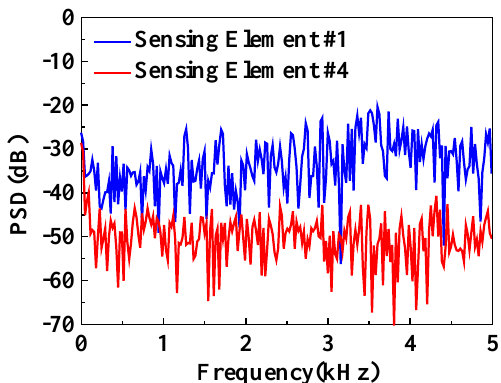
Figure 10. Power spectral density (PSD) comparison of detected signals acquired by the sensing elements #1 and #4 at a pulse repetition rate of 10 kHz.